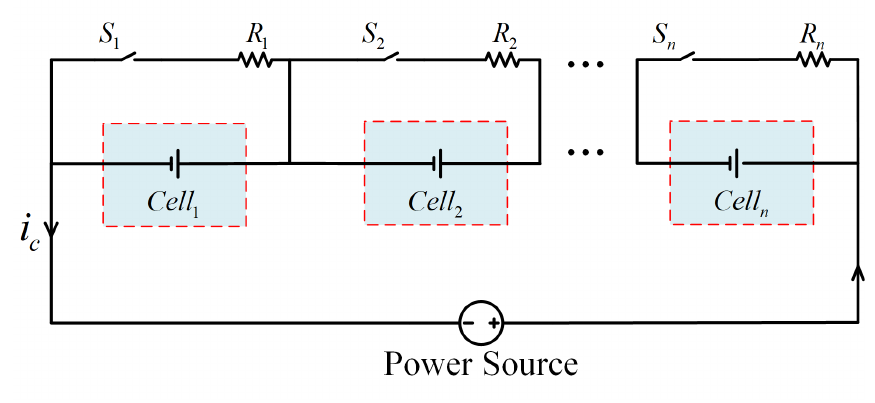
Figure 3. The balancing circuit model